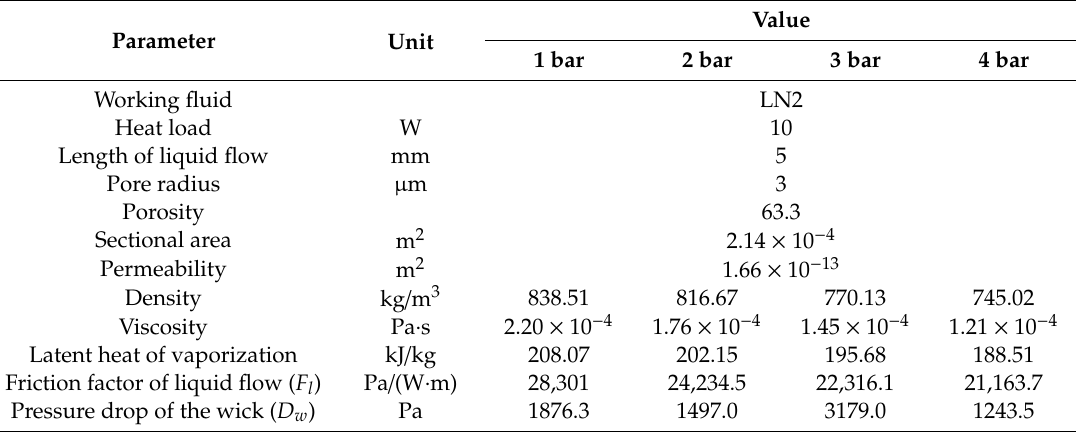
Table 4. The pressure drop of the wick due to liquid flow in the evaporator.